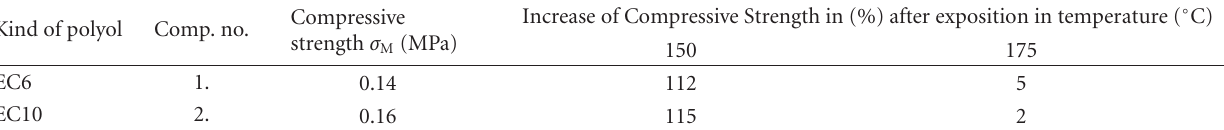
Table 6: Compressive strength of polyurethane foams (MPa).